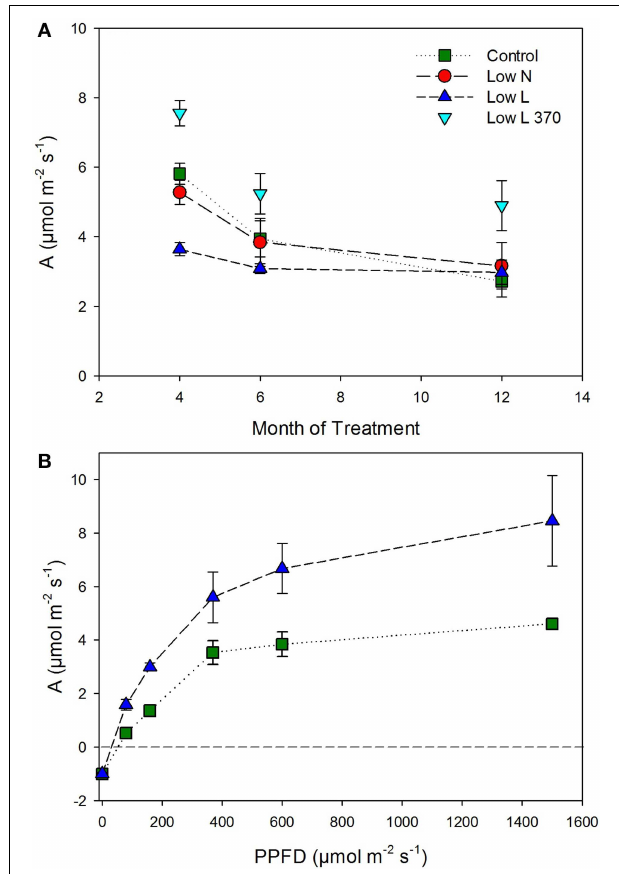
FIGURE 2 | (A) Photosynthetic rate (A) under experimental conditions (control and Low N 370 µ mol m − 2 s − 2 ; Low L 160 µ mol m − 2 s − 2 ) and additionally for Low L plants at 370 µ mol m − 2 s − 2 ( n = 4 ± SE). (B) Light-response curves of photosynthesis for Low L and control plants, measured after 6 months of treatment ( n = 3 ±